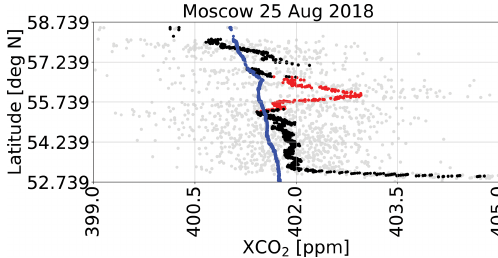
Figure 2. An example of the background and anomaly calcula- tion procedure for OCO-2 data over Moscow (Russia) on 25 Au- gust 2018. The grey points represent the original measurements from the OCO-2 Lite files. The OCO-2 ground track in this example is downwind of the city and perpendicular to the wind direction. The black and red points indicate the smoothed data, with the red points corresponding to where the Gaussian plume intersects the OCO-2 track. We consider the red points to be within the urban enhance- ment plume of the city. The blue line shows the derived background using the lowest 75% percent of